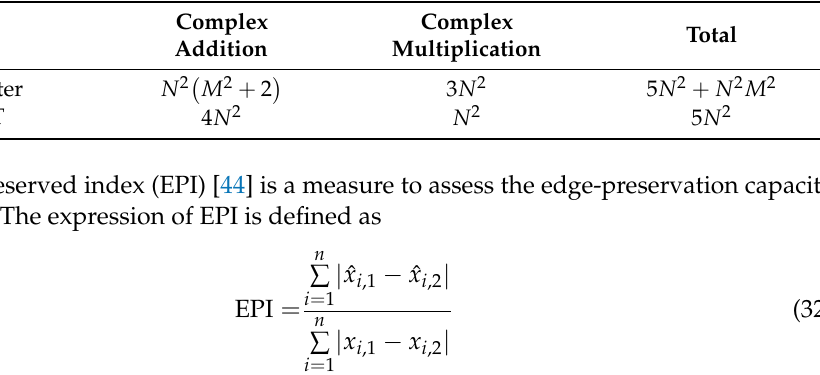
Figure 11. The image result of Lee filter and NSST. ( a ) The reference image. ( b ) The reference image with noisy. ( c ) The image result of Lee filter. ( d ) The image result of NSST. Table 1. Complexity analysis of different filtering Table 2. Measured parameters of different filtering algorithm.